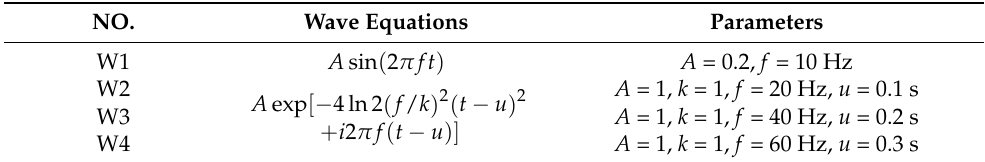
Table 1. Parameters of the four wavelets (Figure